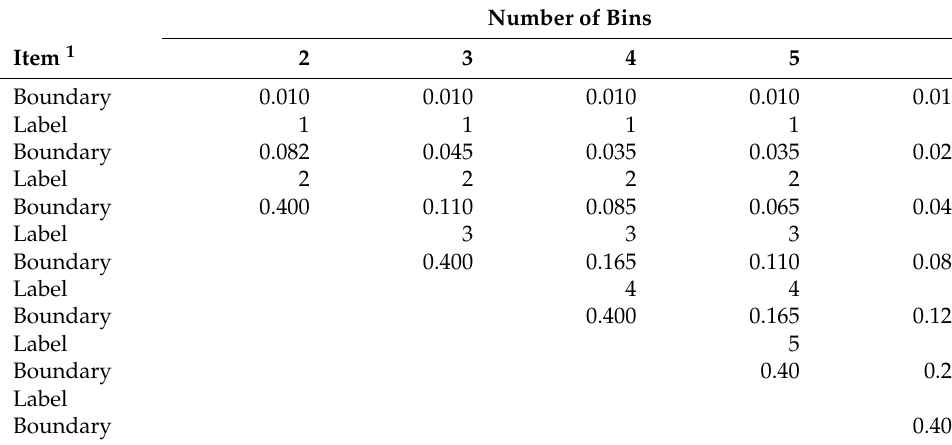
Boundaries separating bins for planned contributions to enable testing for equality of variance among levels of planned contributions are int Table A3. Granularity increases with number of bins. The maximum number of bins would be the number of unique values for planned contributions. Table A3. Boundaries between bins for planned contribution